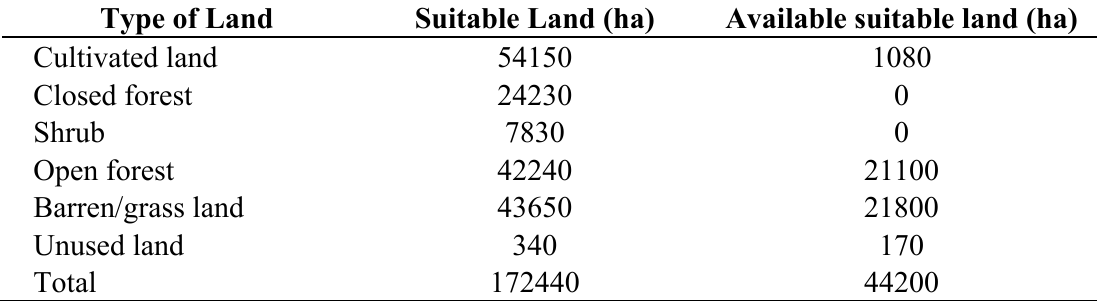
Table 4. Land suitable for Jatropha plantation in